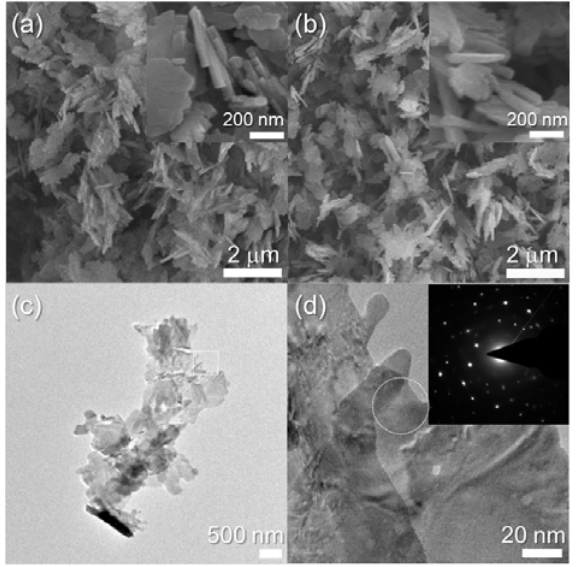
Figure 3. SEM and TEM images of 0.76Cr-CuO nanosheets. ( a ) SEM image of as-prepared 0.76Cr-CuO nanosheets, ( b ) SEM image of 0.76Cr-CuO nanosheets after heat treatment at 500 °C for 1 h , and ( c , d ) TEM images and SAED pattern of 0.76Cr-CuO nanosheets after heat treatment at 500 °C for 1 h